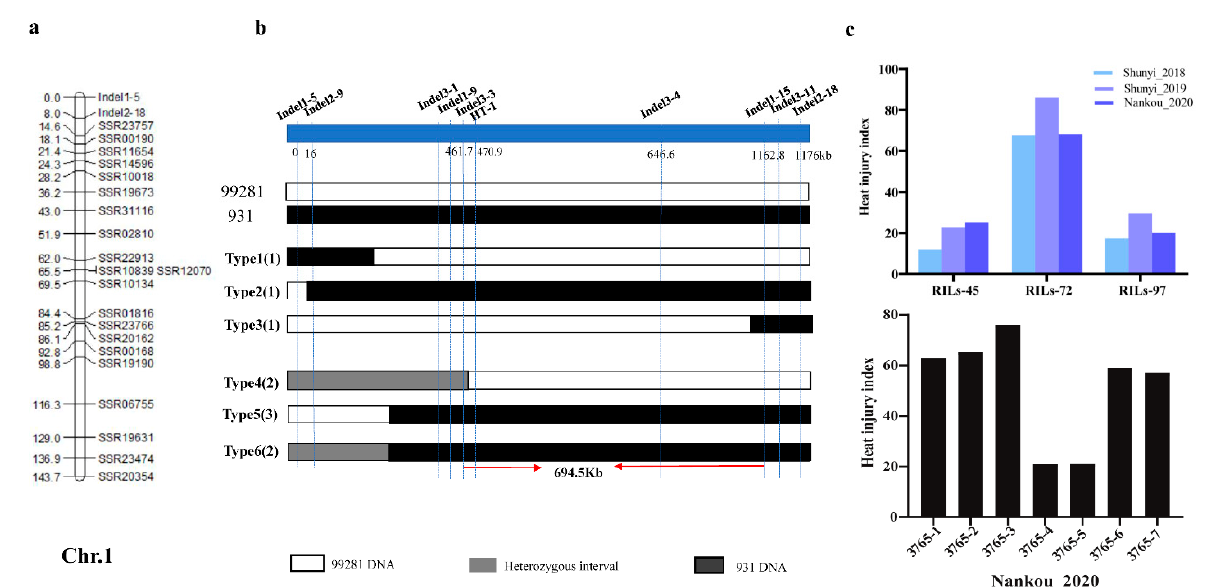
Figure 5. Fine mapping of qHT1.1 . ( a ) QTL mapping of qHT1.1 in 2018, 2019, and 2020. ( b ) A total of 10 Indel markers were used to fine map the qHT1.1 to a 694.5-Kb region on Chr.1. ( c ) The phenotypic data of RIL population and F 2 population. Type1, Type2, and Type3 represent RIL-45, RIL-72, and RIL-97, respectively. Type4 represents 3765-4 and 3765-5. Type5 represents 3765-1, 3765-2, and 3765-3. Type6 represents 3765-6 and 3765-7.